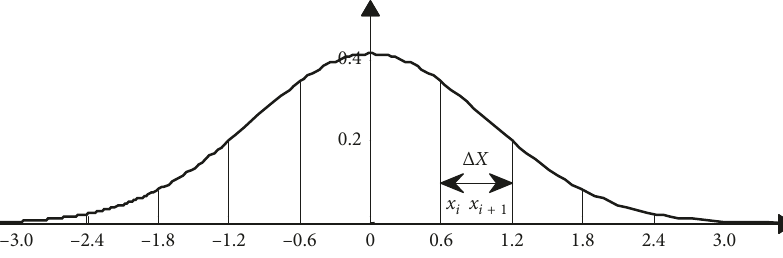
Figure 4: Schematic diagram for discretization of standardized normal distribution.